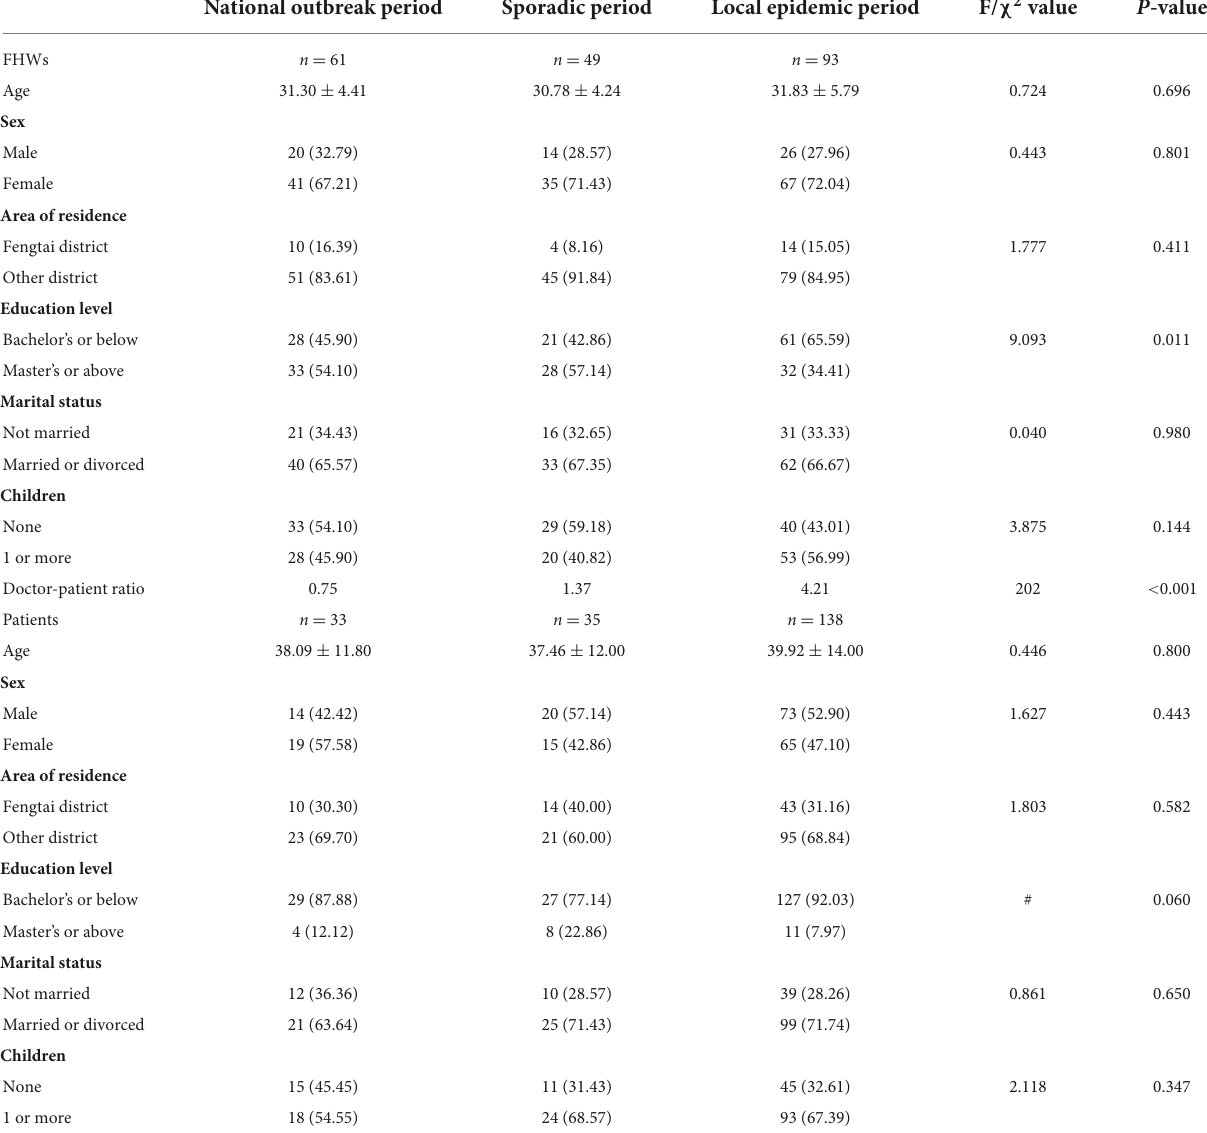
TABLE 1 The demographic characteristics of enrolled health care workers and patients during the national outbreak period, sporadic period and local epidemic